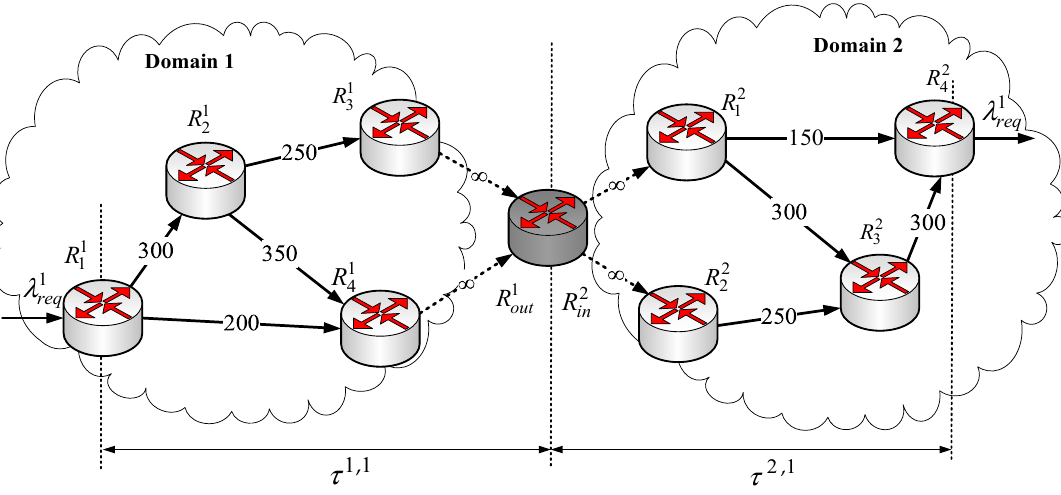
Figure 3. Principle of introducing imaginary routers and links into the network structure.